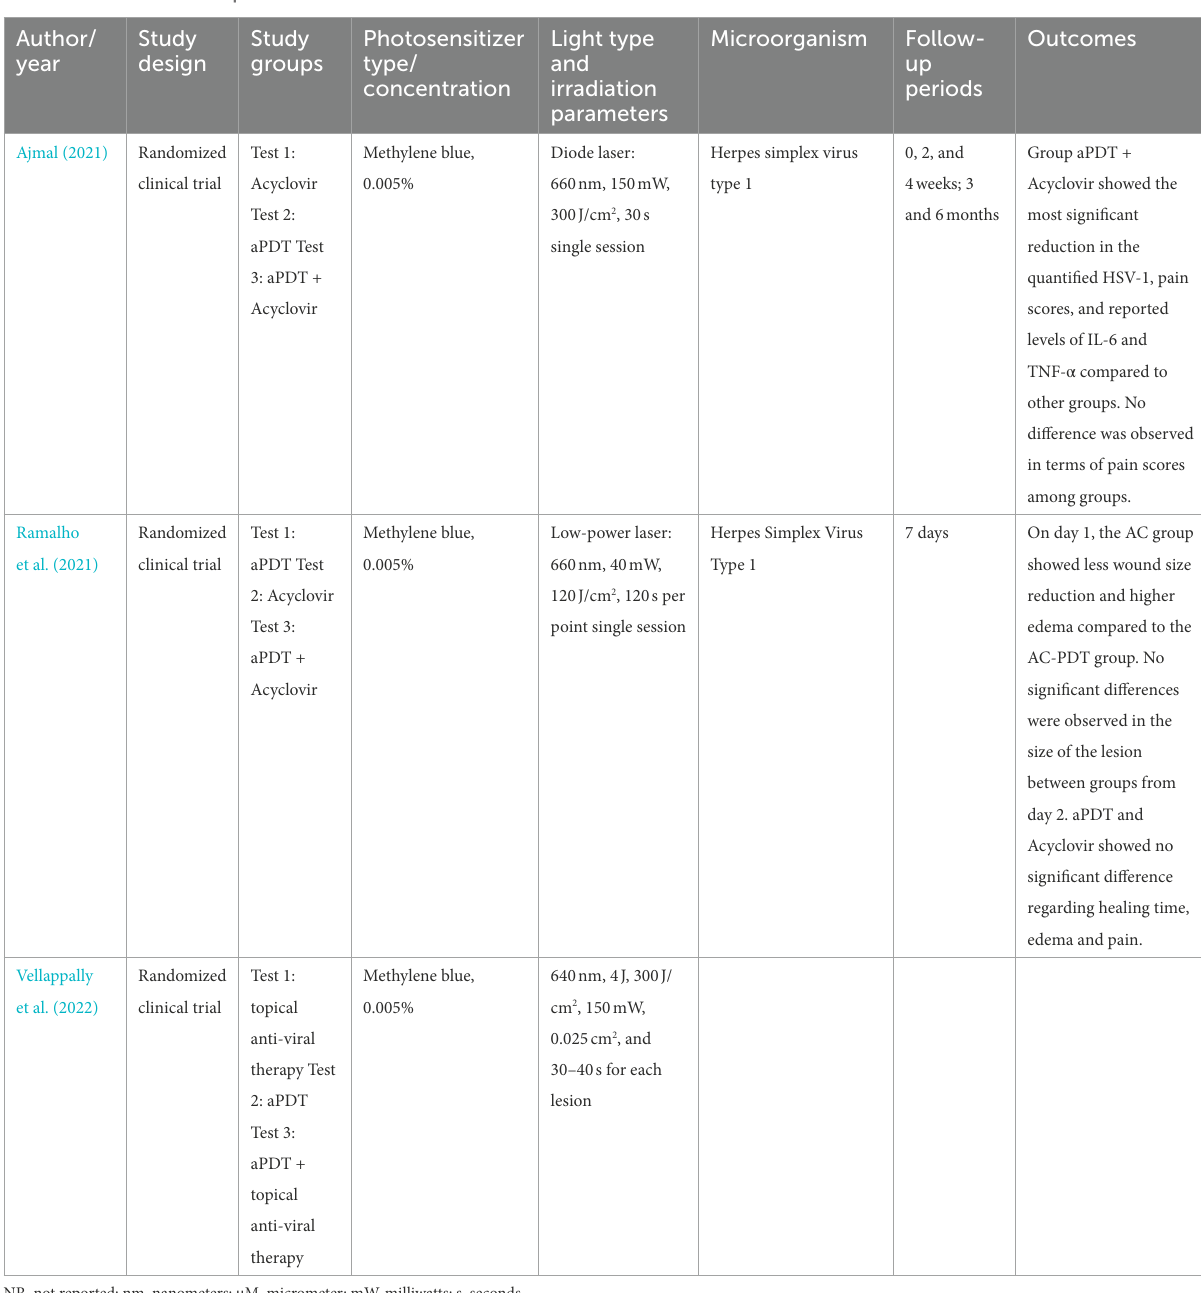
TABLE 6 aPDT treatment in patients with oral viral